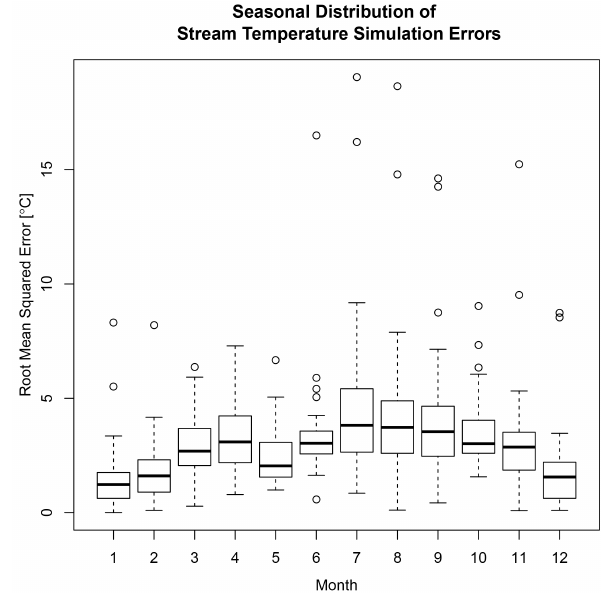
Figure 3. Monthly stream temperature error distributions for all stream temperature gauges. This modified “box and whisker” plot shows 1st and 3rd quartiles ( Q 1 and Q 3 ) as the lower and upper box edges, respectively, and medians as bold lines. The lower whisker is defined by Q 1 − 1.5 · ( Q 3 − Q 1 ), and the upper whisker is defined by Q 3 + 1.5 · ( Q 3 − Q 1 ). Outliers are designated as open